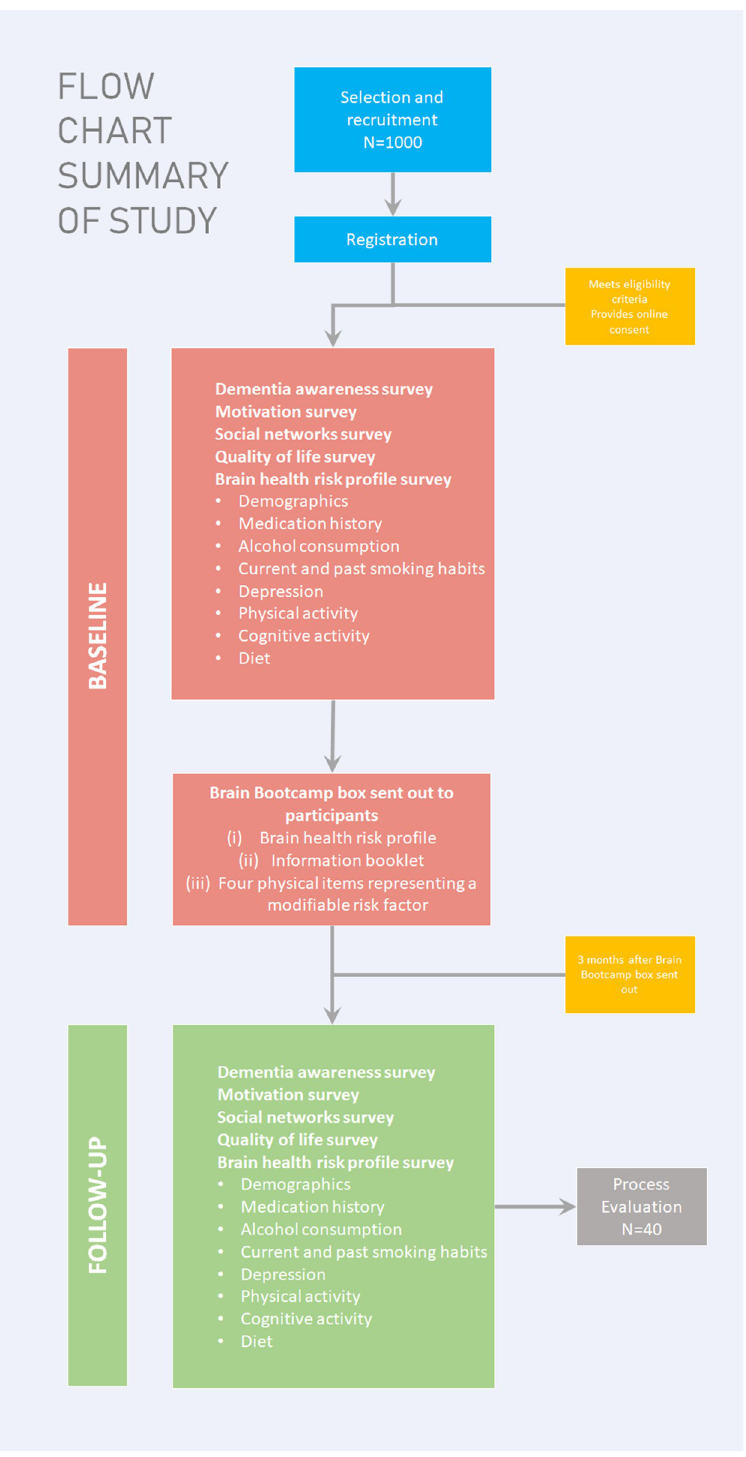
Fig 2. Flow chart summary of